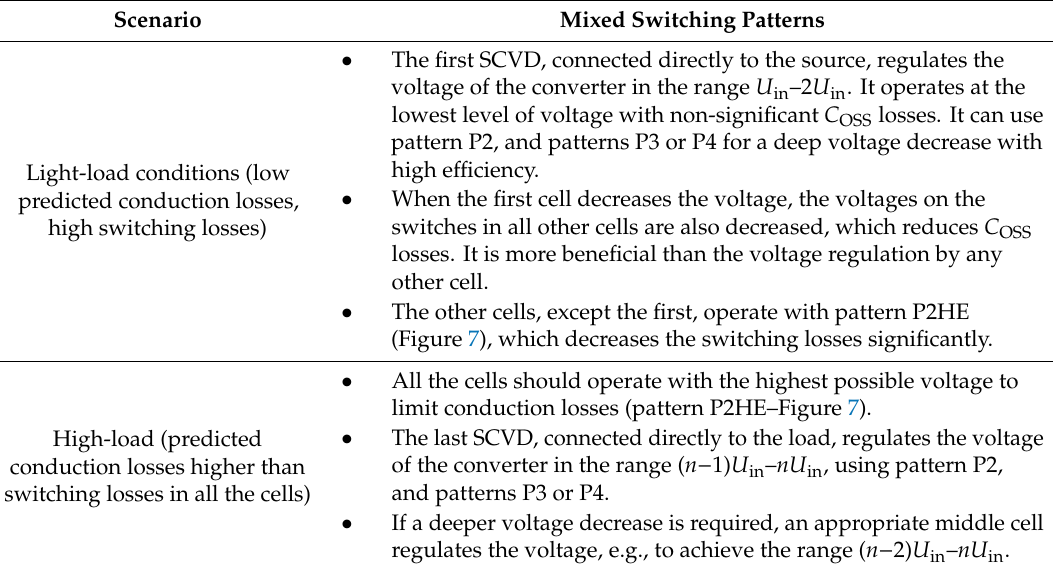
Table 2. Examples of scenarios for series SCVD optimal switching.